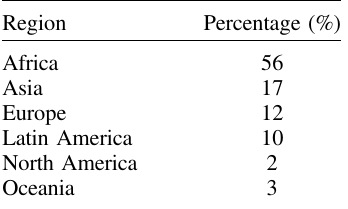
Table 2. Geographic distribution of the participants attending the ICTP-BC-UNOOSA